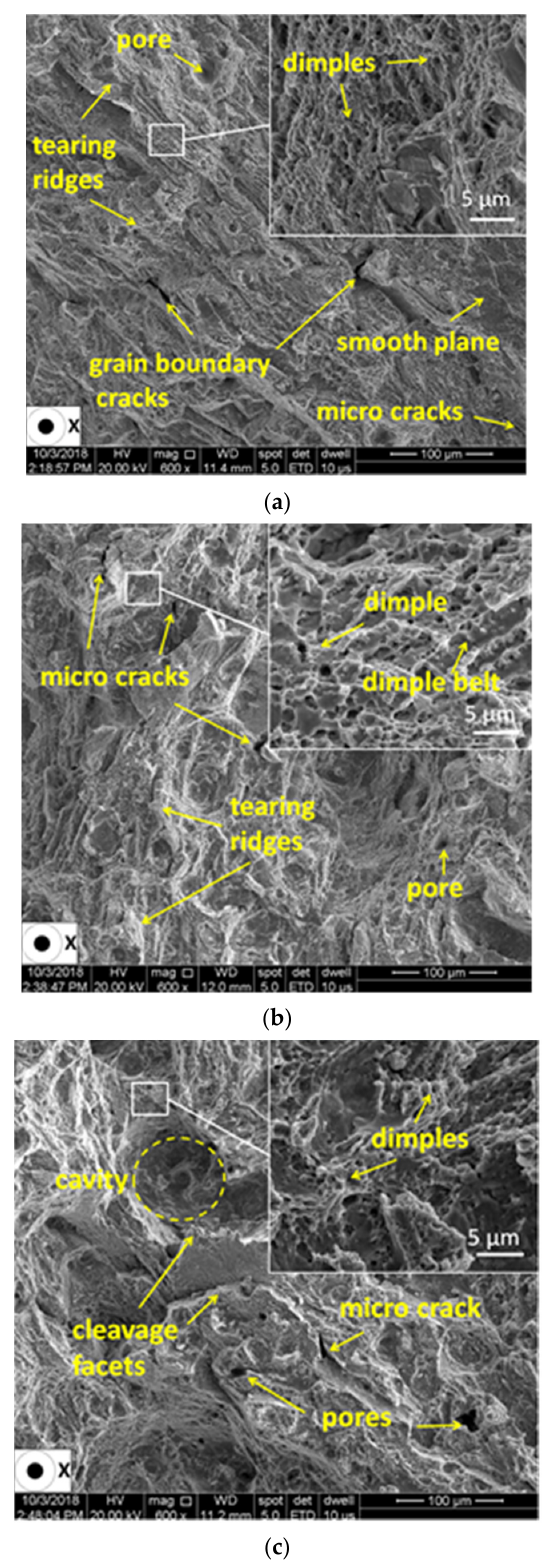
Figure 18. Fractographs of a smooth test piece ( a ) and a V-notched test piece. With root radii of 0.05 mm ( b ) and 0.63 mm ( c ), tested in the stress-relieved state.